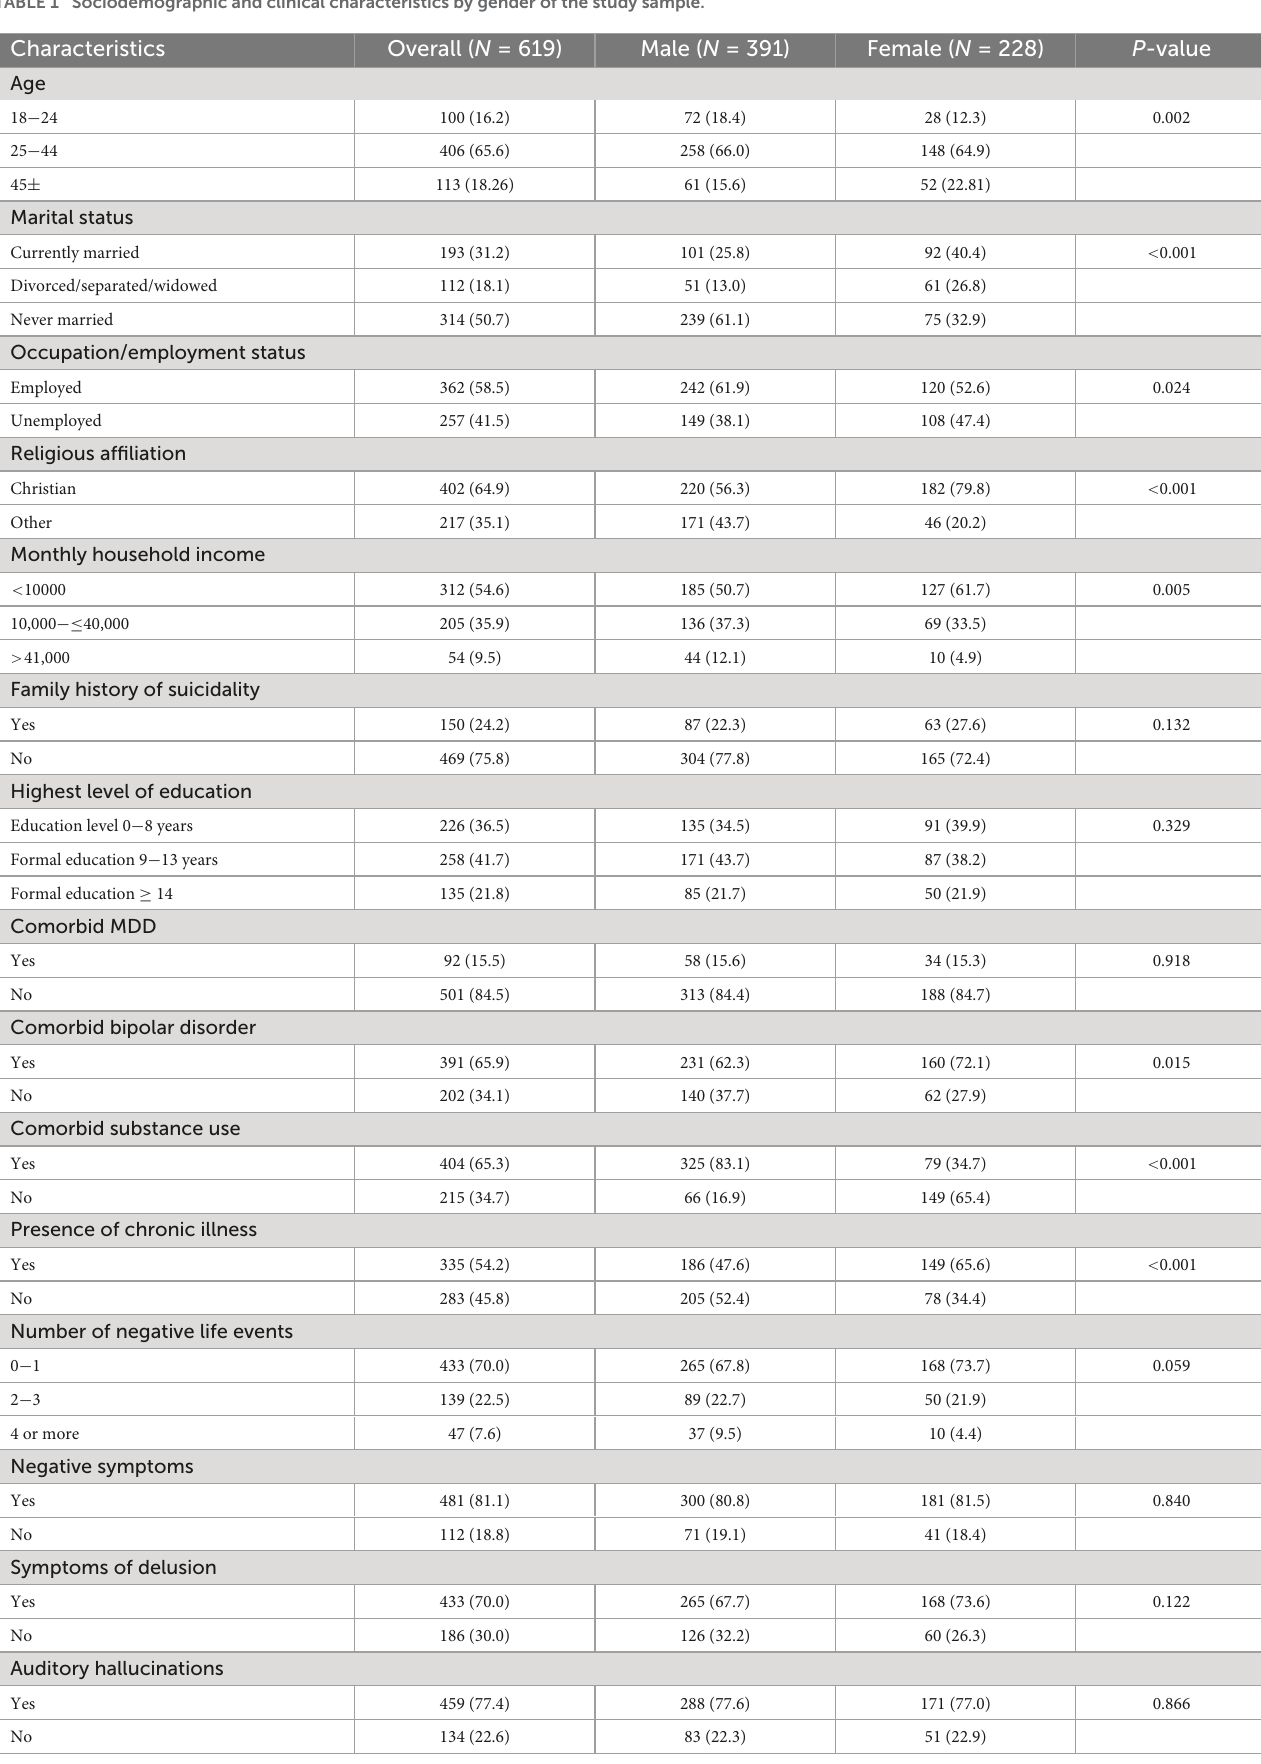
TABLE 1 Sociodemographic and clinical characteristics by gender of the study sample.